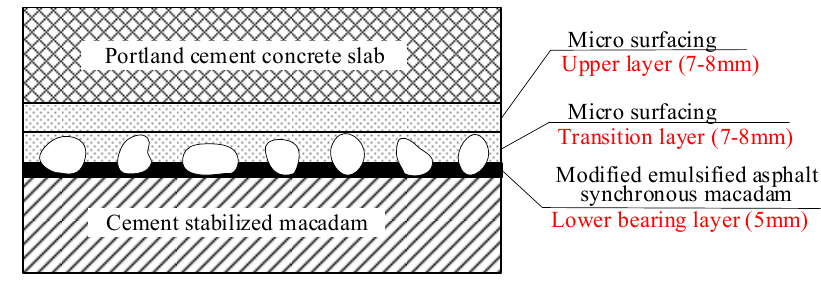
Figure 1. Structure of composite separator layer.